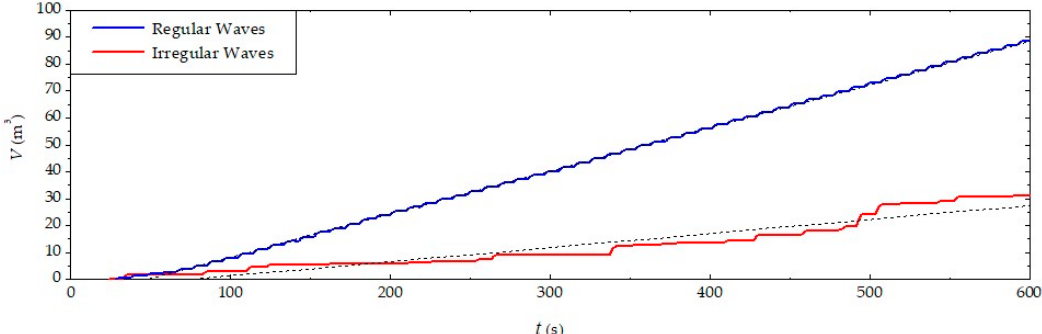
Figure 16. Volume of water accumulated in the reservoir over time due to the incidence of the representative regular waves and realistic irregular waves for RG.